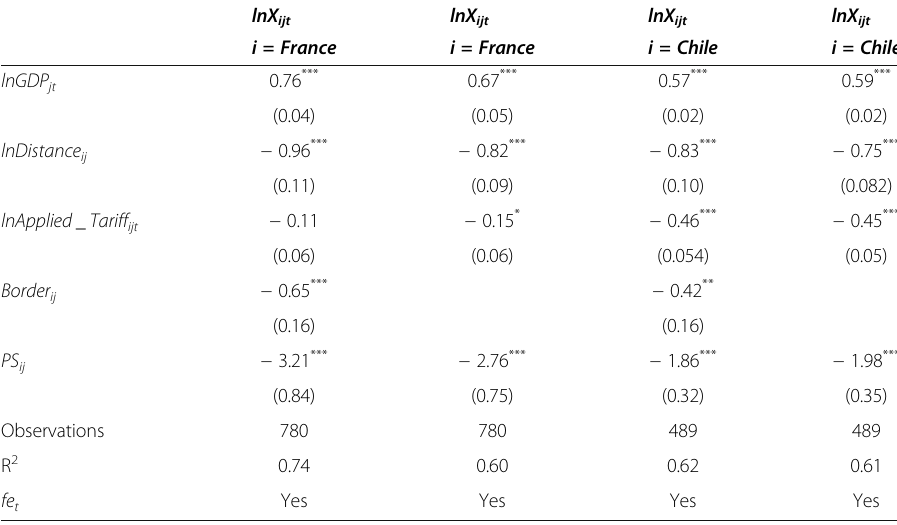
Table 3 Results of the PPML estimator by